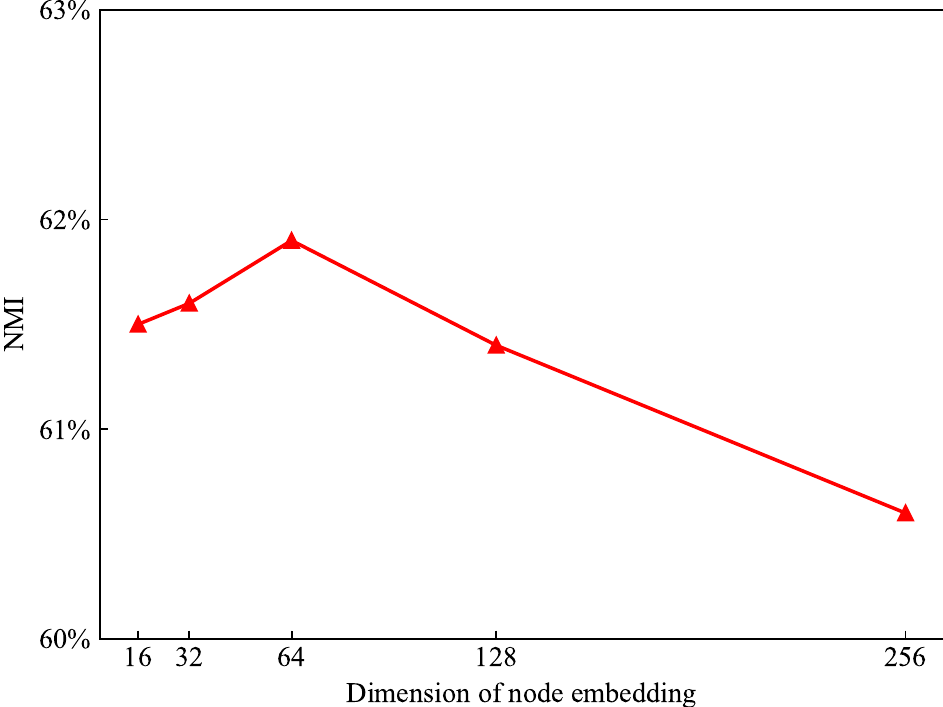
Figure 8. Node embedding